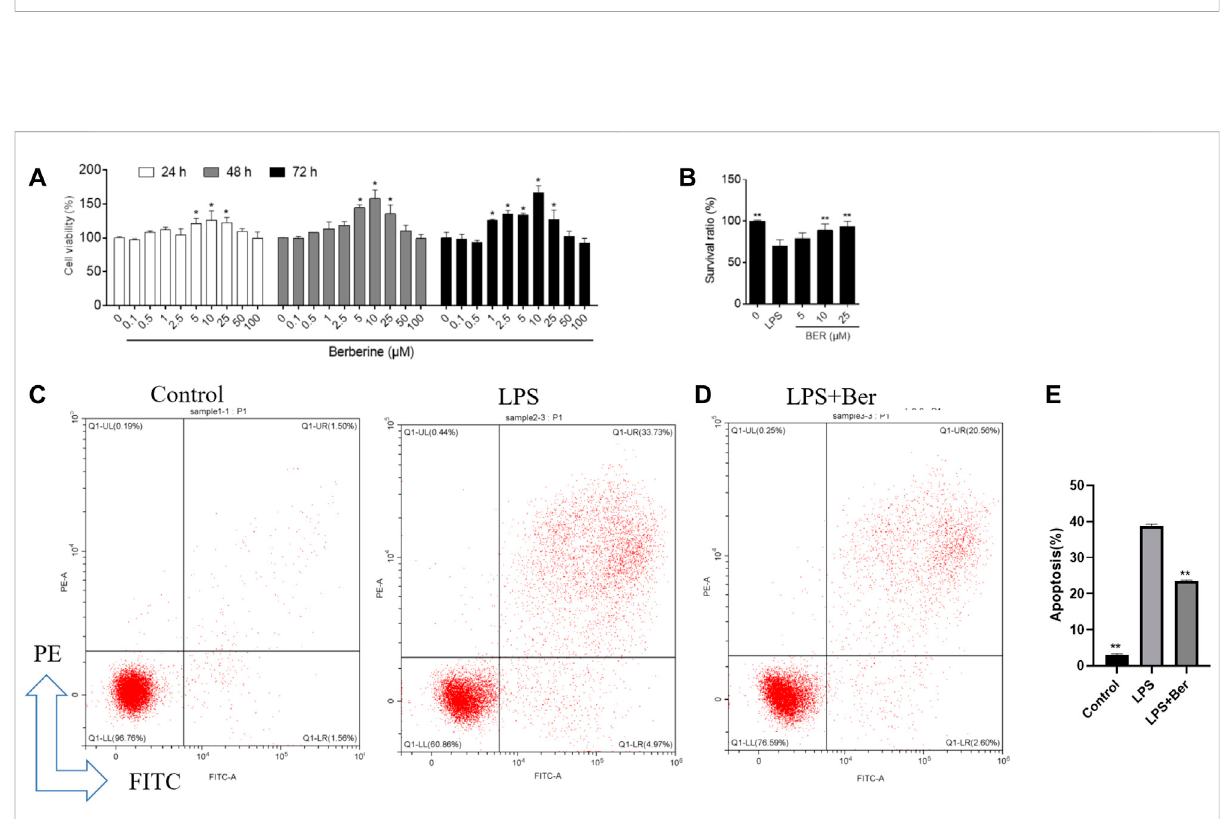
FIGURE 7 (A) ,Cellularviabilityusingcellcountingkit-8assayon24,48,and72 hfollowingtreatmentwithdifferentconcentrationsofberberine.* p < 0.05, compared with the control group on day 5. # p < 0.01. (B) Effect of berberine on HGFs viability on 24 h with different concentrations of berberine (5, 10, and 25 μ M). (C,D) Flow cytometry analysis was conducted to examine the effects of LPS and berberine on apoptosis in HGFs on 24 h (berberine, 10 uM,LPS, 1 μ g/ml).Early(annexin-Vpos/PIneg)and late (annexin-Vpos/PIpos)apoptotic cells can bediscriminated fromvital (Annexin-Vneg/ PIneg) or necrotic (annexin-Vneg/PIpos) cells according to their fl uorescence emission. (E) Dot plots representative of 24 h treated cells are shown. The graph shows the mean cell percentages (±SD, n = 3) of viable, early, and late apoptotic and necrotic